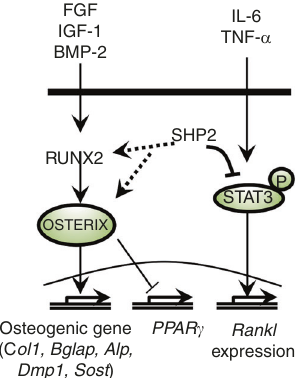
Fig. 7 Diagrams demonstrate the molecular model by which SHP2 regulates osteoblast and osteocyte maturation and local osteoclas- togenesis. SHP2 is physiologically required for osteoblast maturation by modulating the expression of OSTERIX and its responsive osteogenic genes and for local osteoclastogenesis regulation by repressing STAT3 phosphorylation and activation and RANKL expression,